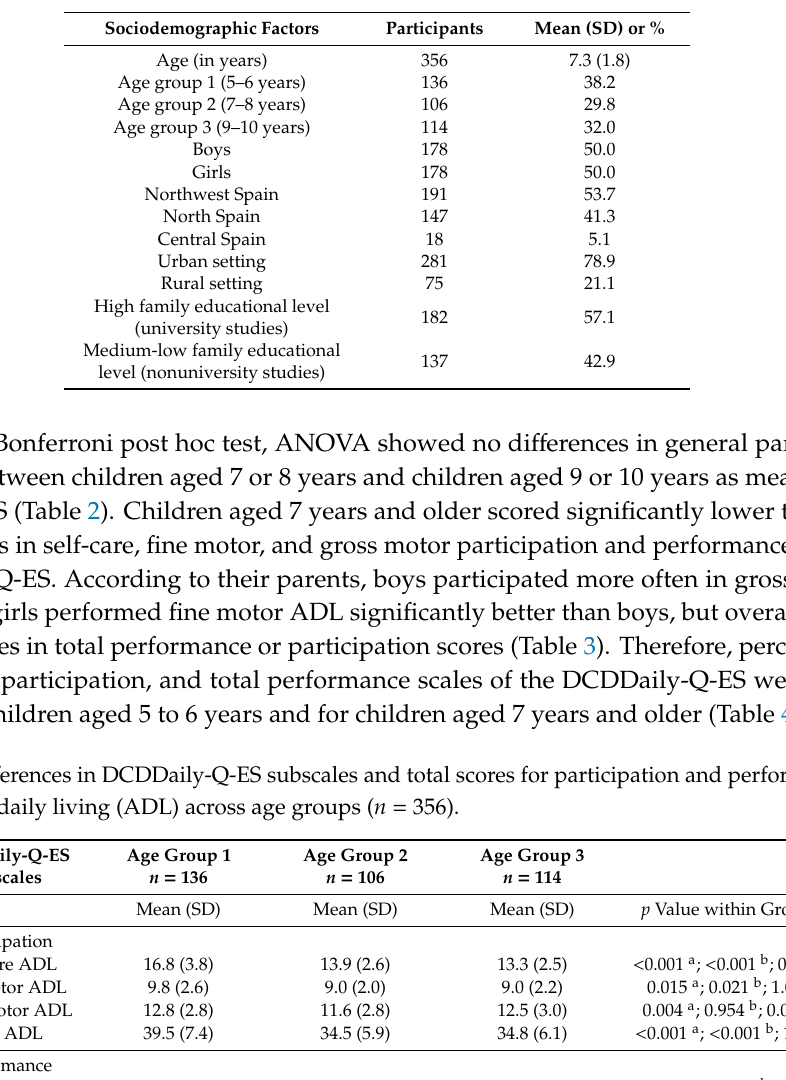
Table 1. Sociodemographic characteristics of the sample ( n = 356).